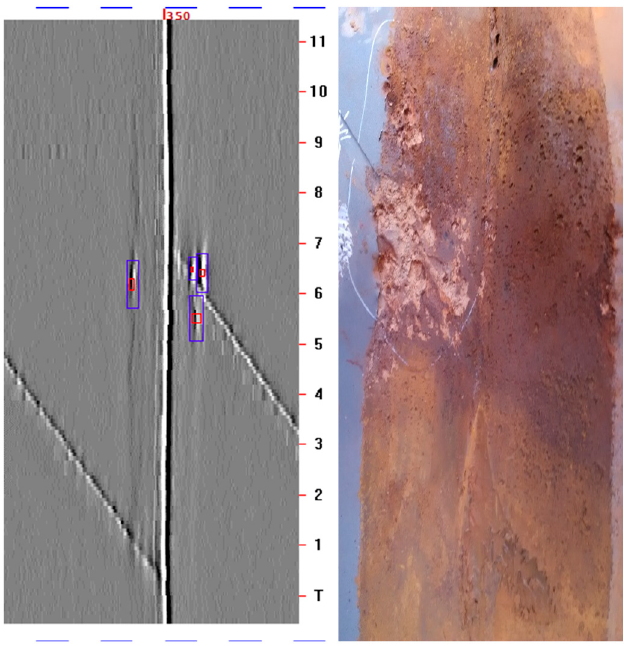
Figure 13. Typical signals and excavation pictures for type 3.